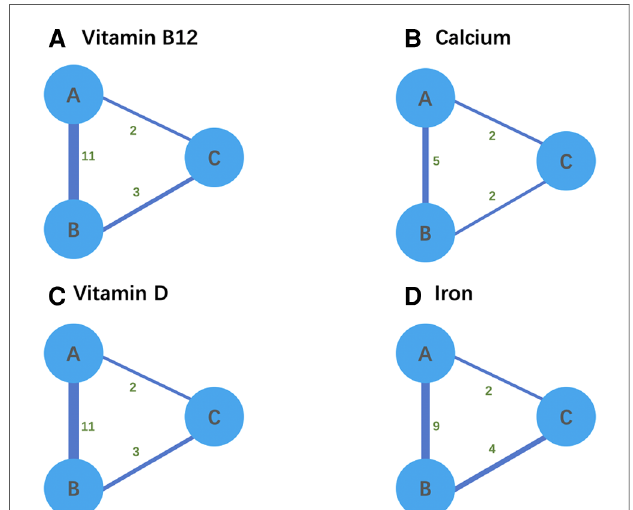
FIGURE 2 ( A – D ) Network relationship diagram for network meta-analysis. Thicker lines ndicate a greater cumulative number of enrolled studies per direct comparison. A refers to LSG, B refers to RYGB, and C refers to AGB.